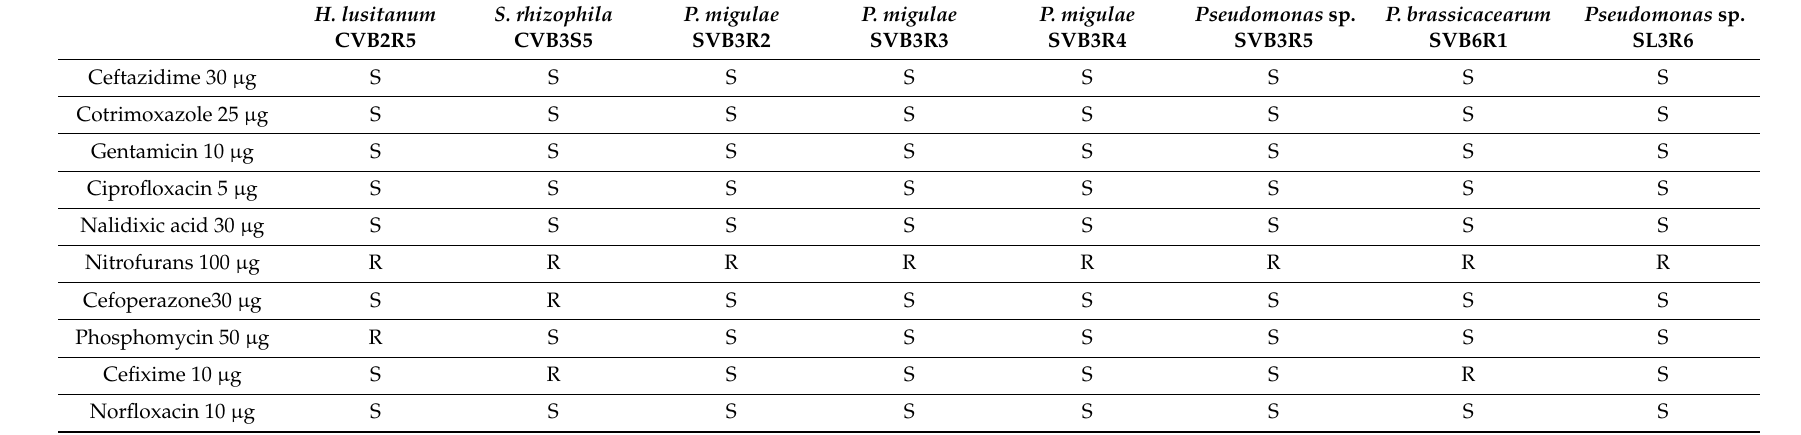
Table 2. Sensitivity (S) or resistance (R) of eight selected bacterial endophytes to di ff erent